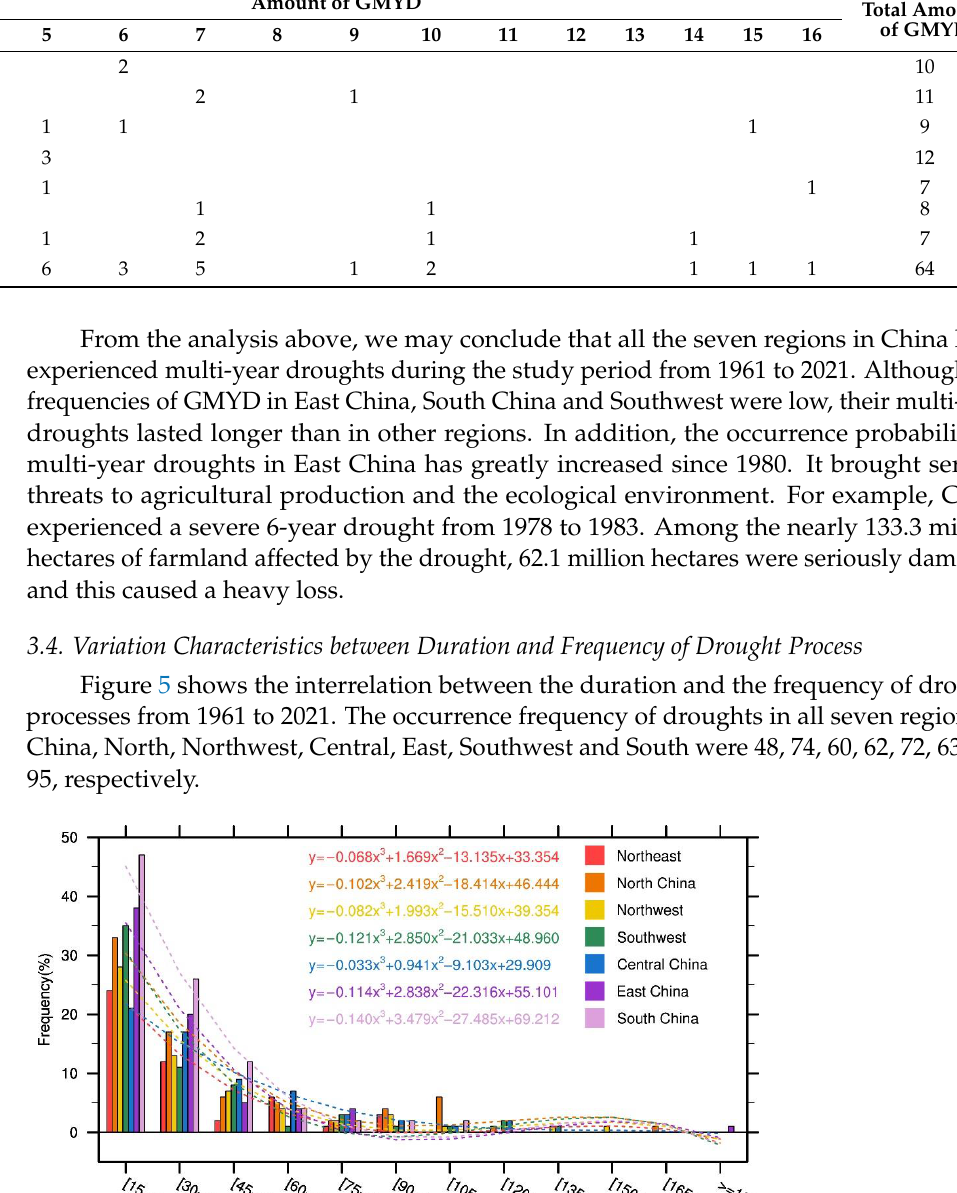
Table 1. Statistics of GMYDs in all seven regions of China from 1961 to 2021.